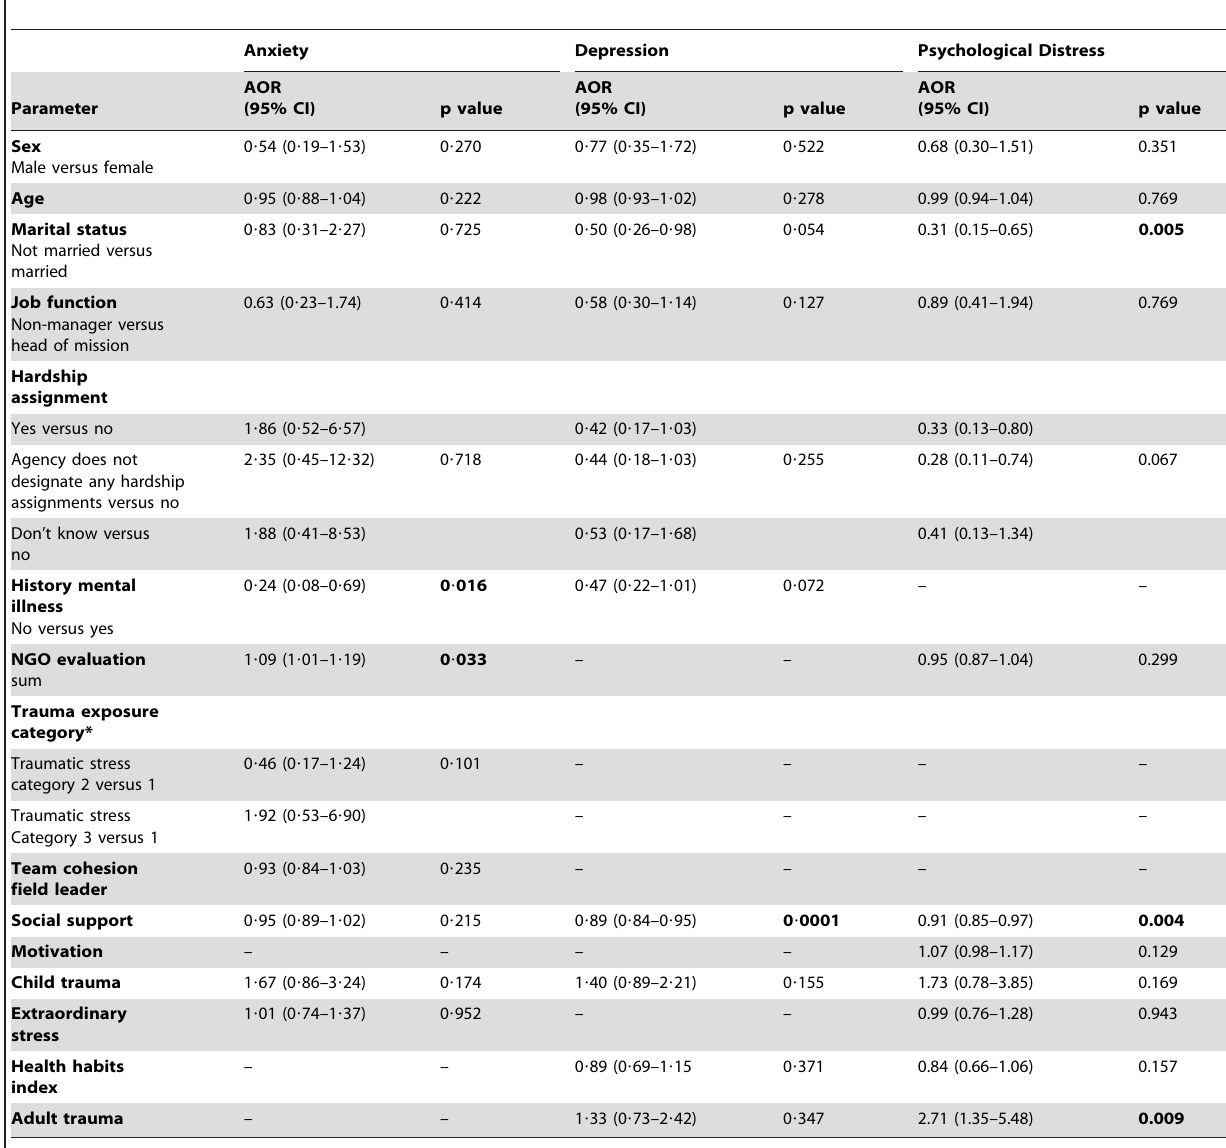
Table 3. Longitudinal multivariate generalized estimating equations models: demographic variables, exposure, organizational and other risk and mitigating factors across time affecting anxiety, depression, and psychological